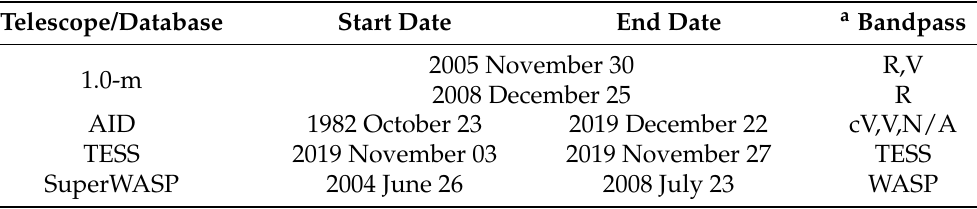
Table 1. Details of new